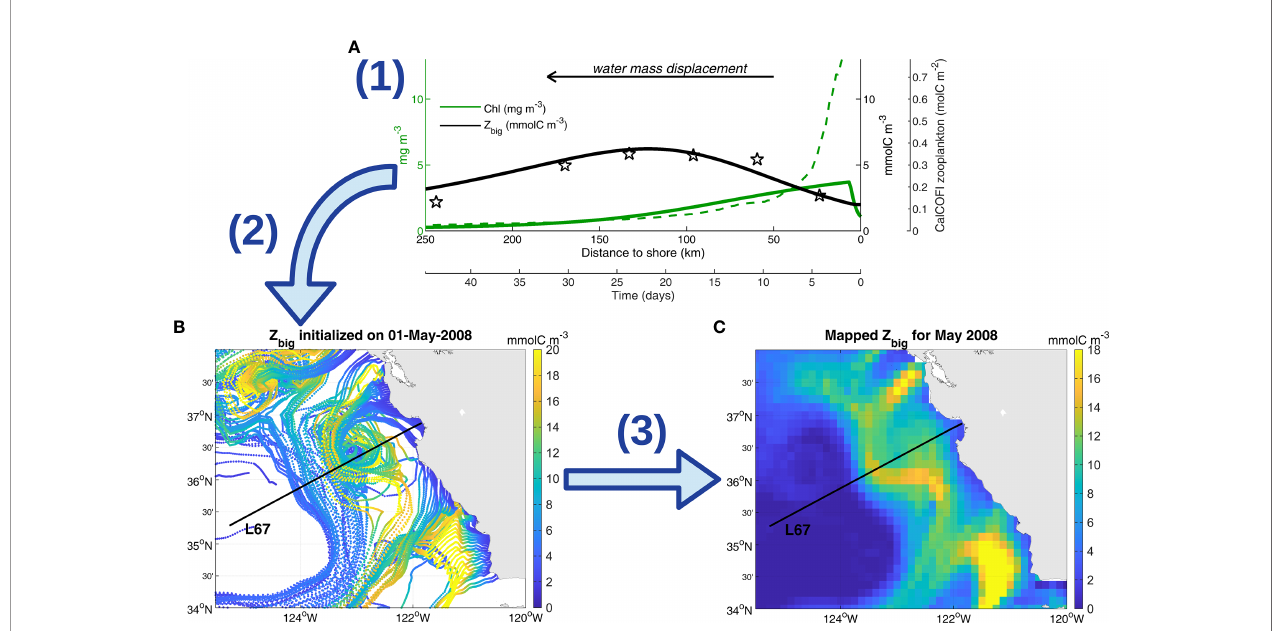
FIGURE 1 | Growth-advection method schematic. (A) Example of NPZ model output (step 1), initialized using the mean nitrate supply off Monterey Bay at 36.8°N (11 mmolC m -3 d -1 ). Z big (black line) and chlorophyll (green line) outputs are given as a function of time and distance to shore, the correspondence being obtained using a mean offshore speed of 5.6 km d -1 as in Messie ́ and Chavez (2017). The result is compared to data collected along L67: CalCOFI meso- and macrozooplankton (black stars, see Messie ́ and Chavez, 2017) and MODIS satellite chlorophyll (dashed green line, averaged within 5 km of L67). (B) Example of a daily run (initialized on May 1st, 2008) where the NPZ model is initialized at each latitude using the local CCMP wind-driven nitrate supply (step 1), and Z big output is mapped onto corresponding 60-day Lagrangian GlobCurrent trajectories initialized at the coast for that latitude (step 2). (C) Example of a monthly map (May 2008) obtained by combining all daily runs into daily maps, further averaged monthly (step 3). The map for May 2008 encompasses runs starting from March 2nd to May 31st, extracting the parts of the trajectories belonging to